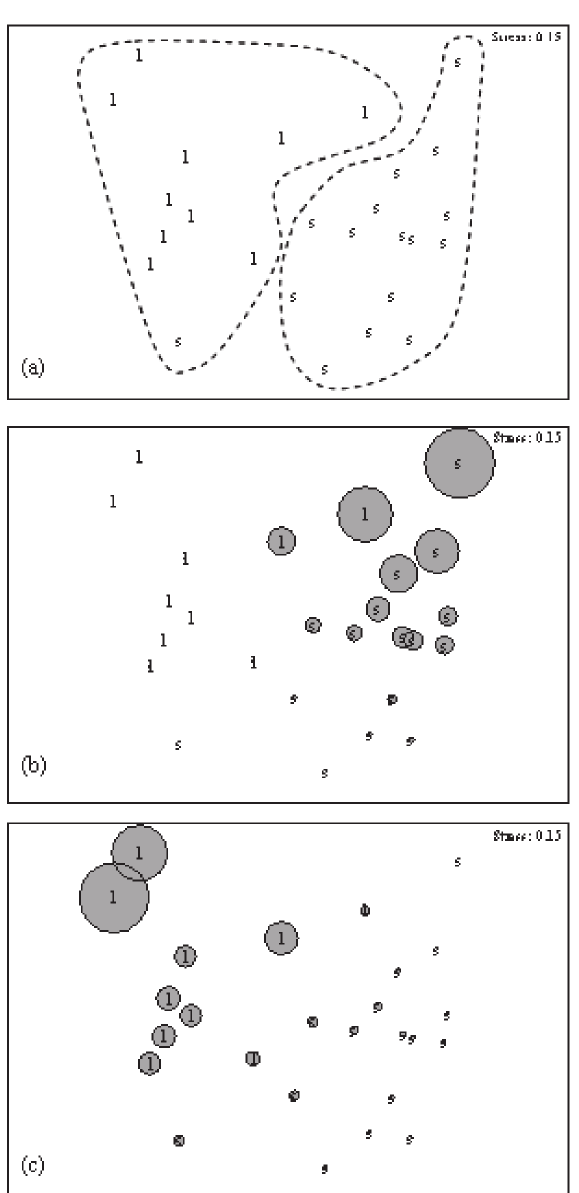
Fig. 5. – MDs analysis of pair-wise similarity matrix derived from numerical abundance of prey categories in each fish size class. (a) MDs plot, s = small fish ( ≤ 43 mm tL); l = large fish (>43 mm tL); bubble plots, showing T. longicornis (b) and A. clausi (c) abundance values superimposed on the relevant MDs ordination